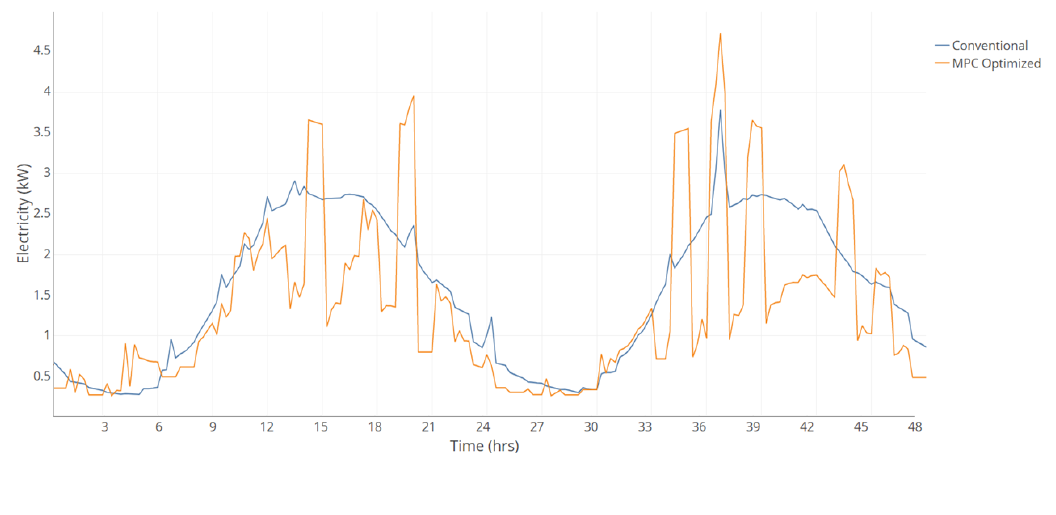
Figure 13. Case 2A electricity consumption for House 1 using individualized hybrid prediction model.